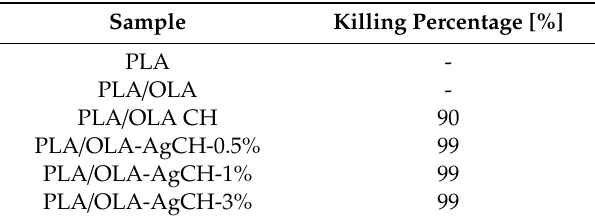
Table 4. Killing percentage for C. parapsilosis fungi by nanocomposite